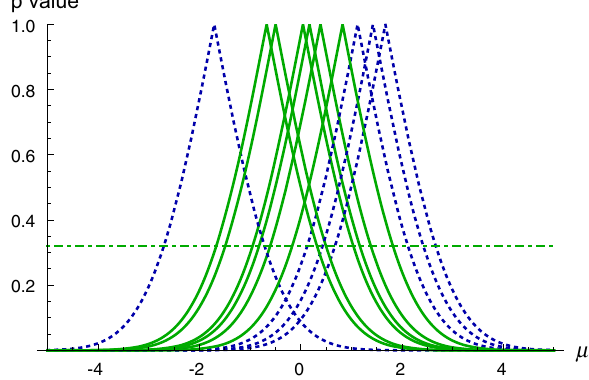
Fig. 3 A α -CL interval built from a p value with exact coverage has a probability of α of containing the true value. This is illustrated in the simple case of a quantity X which has a true value μ t = 0 but is measured with an uncertainty σ = 1. Each time a measurement is performed, it will yield a different value for X 0 and thus a different p value curve as a function of the hypothesis tested μ t = μ . From each measurement, a 68% CL interval can be determined by considering the part of the curve above the line p = 0 . 32, but this interval may or may not contain the true value μ t = 0. The curves corresponding to the first case (second case) are indicated with 6 green solid lines (4 blue dotted lines ). Asymptotically, if the p value has exact coverage, 68% of these confidence intervals will contain the true